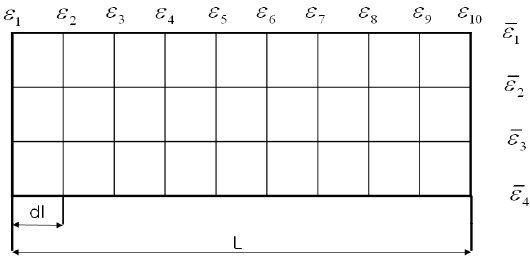
Figure 8. Calculation of the inherent strain.